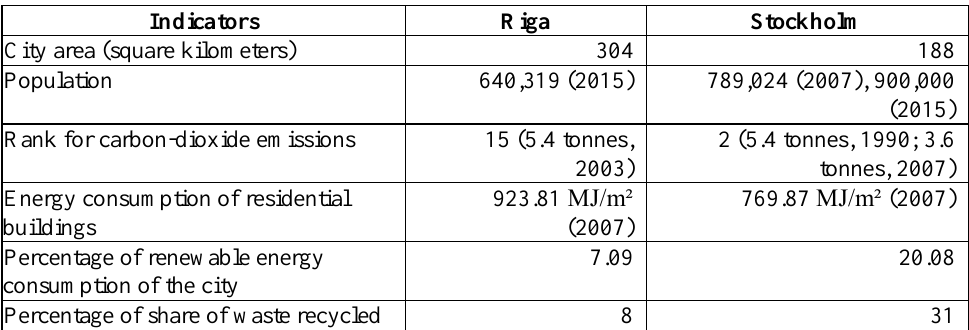
Table 1. Key Comparisons [Based on the previous findings and Siemens